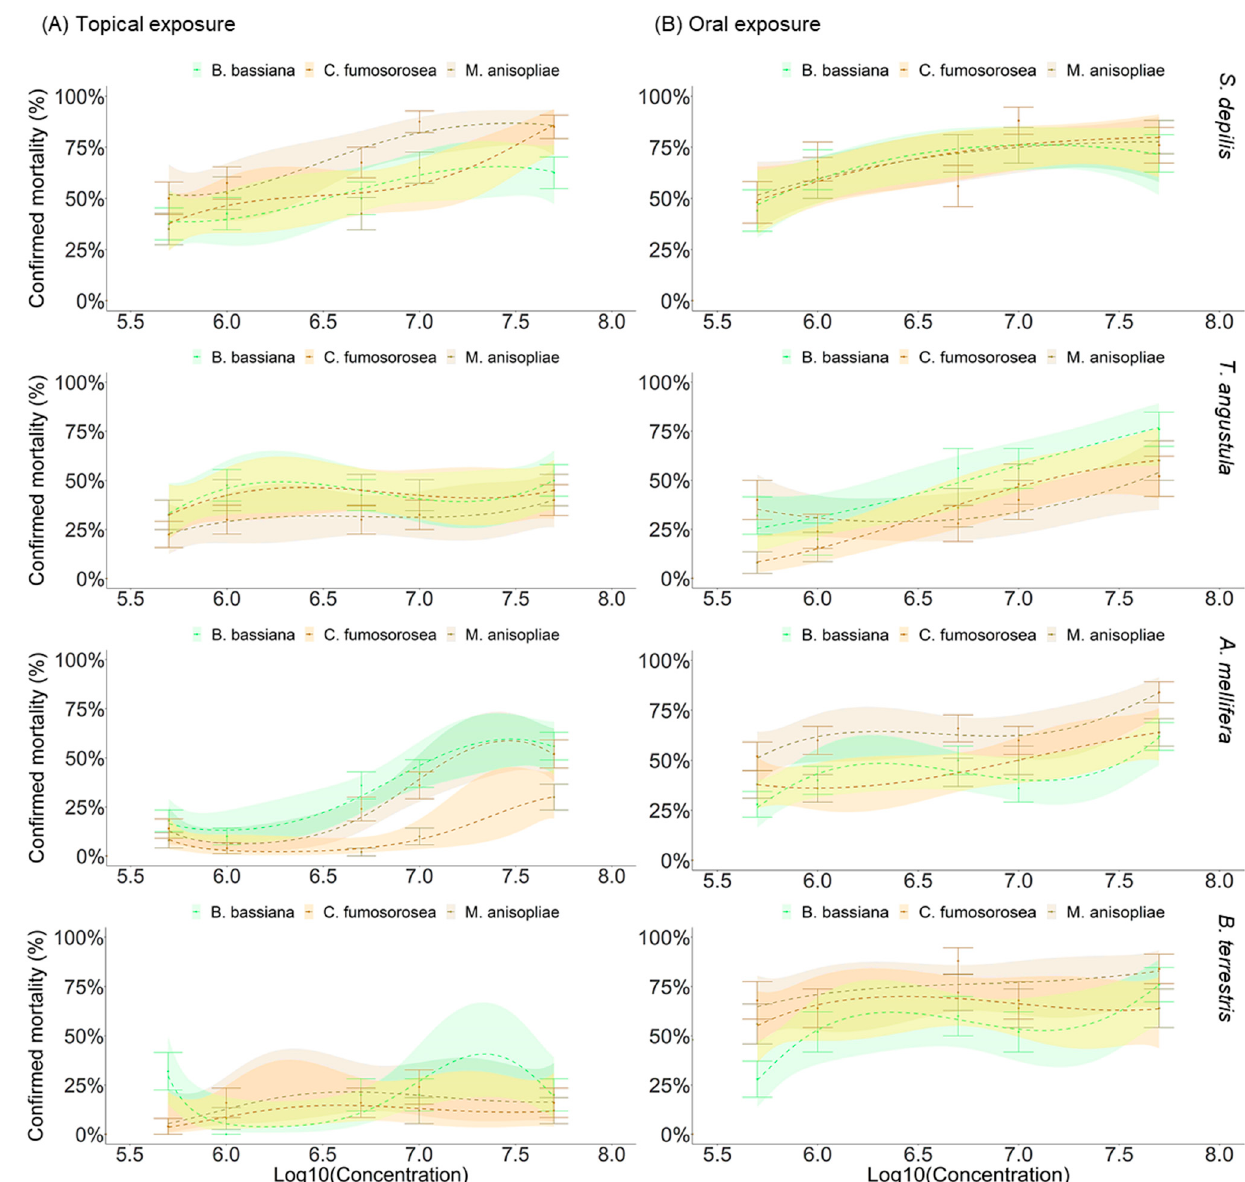
Figure 3. Mean (±SE) percentage of fungal outgrowth curve in dead Scaptotrigona depilis , Tetragonisca angustula , Apis mellifera, and Bombus terrestris workers topically ( A ) and orally ( B ) exposed to the fungi Beauveria bassiana , Metarhizium anisopliae, and Cordyceps fumosorosea . The concentrations (conidia mL − 1 ) were transformed by regression Log10: 4.0 = 5 × 10 5 , 4.5 = 1 × 10 6 , 5.0 = 5 × 10 6 , 5.5 = 1 × 10 7 , 6.0 = 5 × 10 7 . Fitted to generalized linear model (GLM) with binomial distribution.